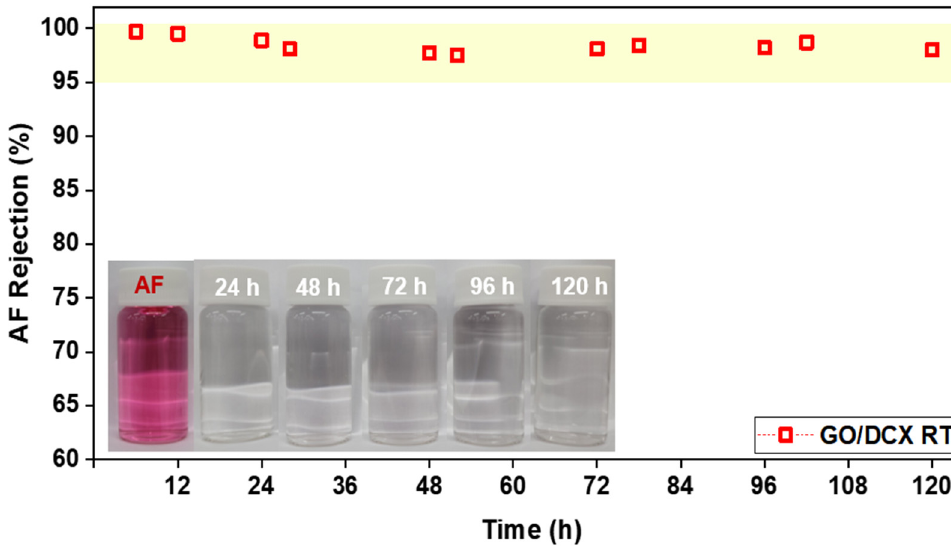
Figure 11. Monitoring of changes in the AF dye rejection efficiencies of the GO/DCX RT membrane during dead-end filtration for long-term stability evaluation (pressure: 1 bar; test duration: 120 h). The inset photograph shows the AF feed (10 mg L − 1 ) and the permeates observed at 24 h intervals during the 120 h filtration